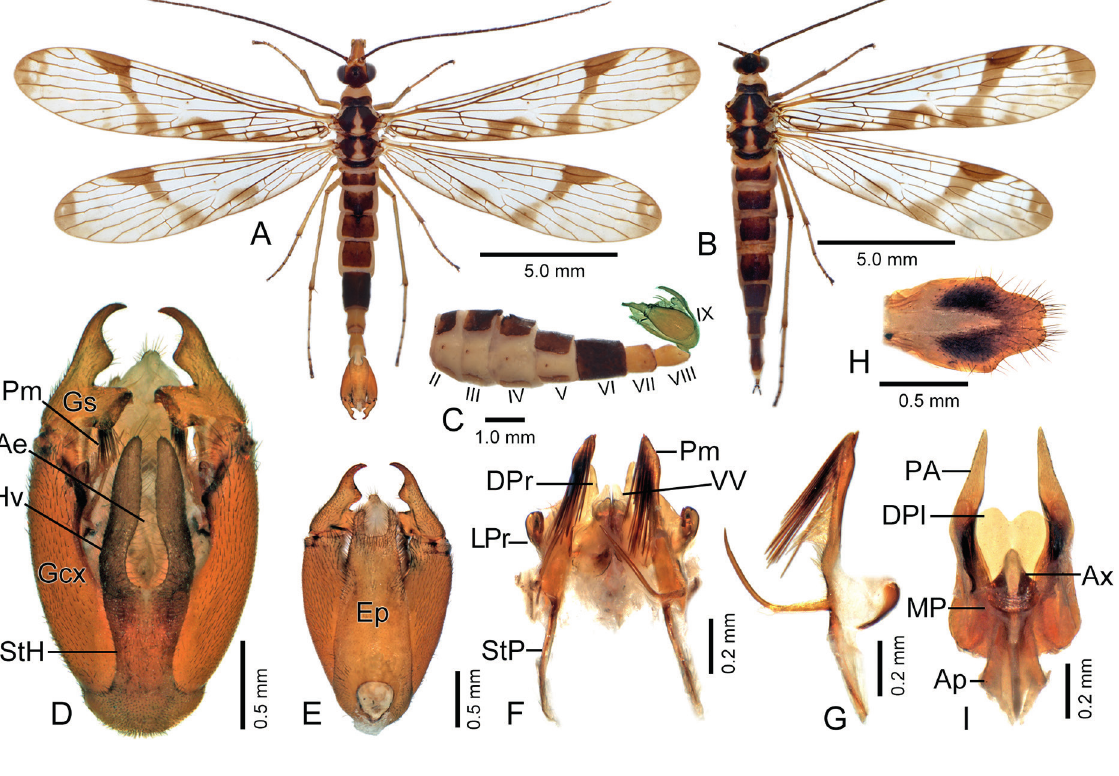
Fig. 3. Panorpa fengyanga sp. nov. A , C – G . Holotype, ♂ (DALU). B , H – I . Paratype, ♀ (DALU). A – B . Habitus, dorsal view. C . Abdomen, left-lateral view. D – E . Genital bulb, ventral and dorsal views, respectively. F . Aedeagal complex, ventral view. G . Right paramere, right-lateral view. H. Subgenital plate, ventral view. I . Medigynium, ventral